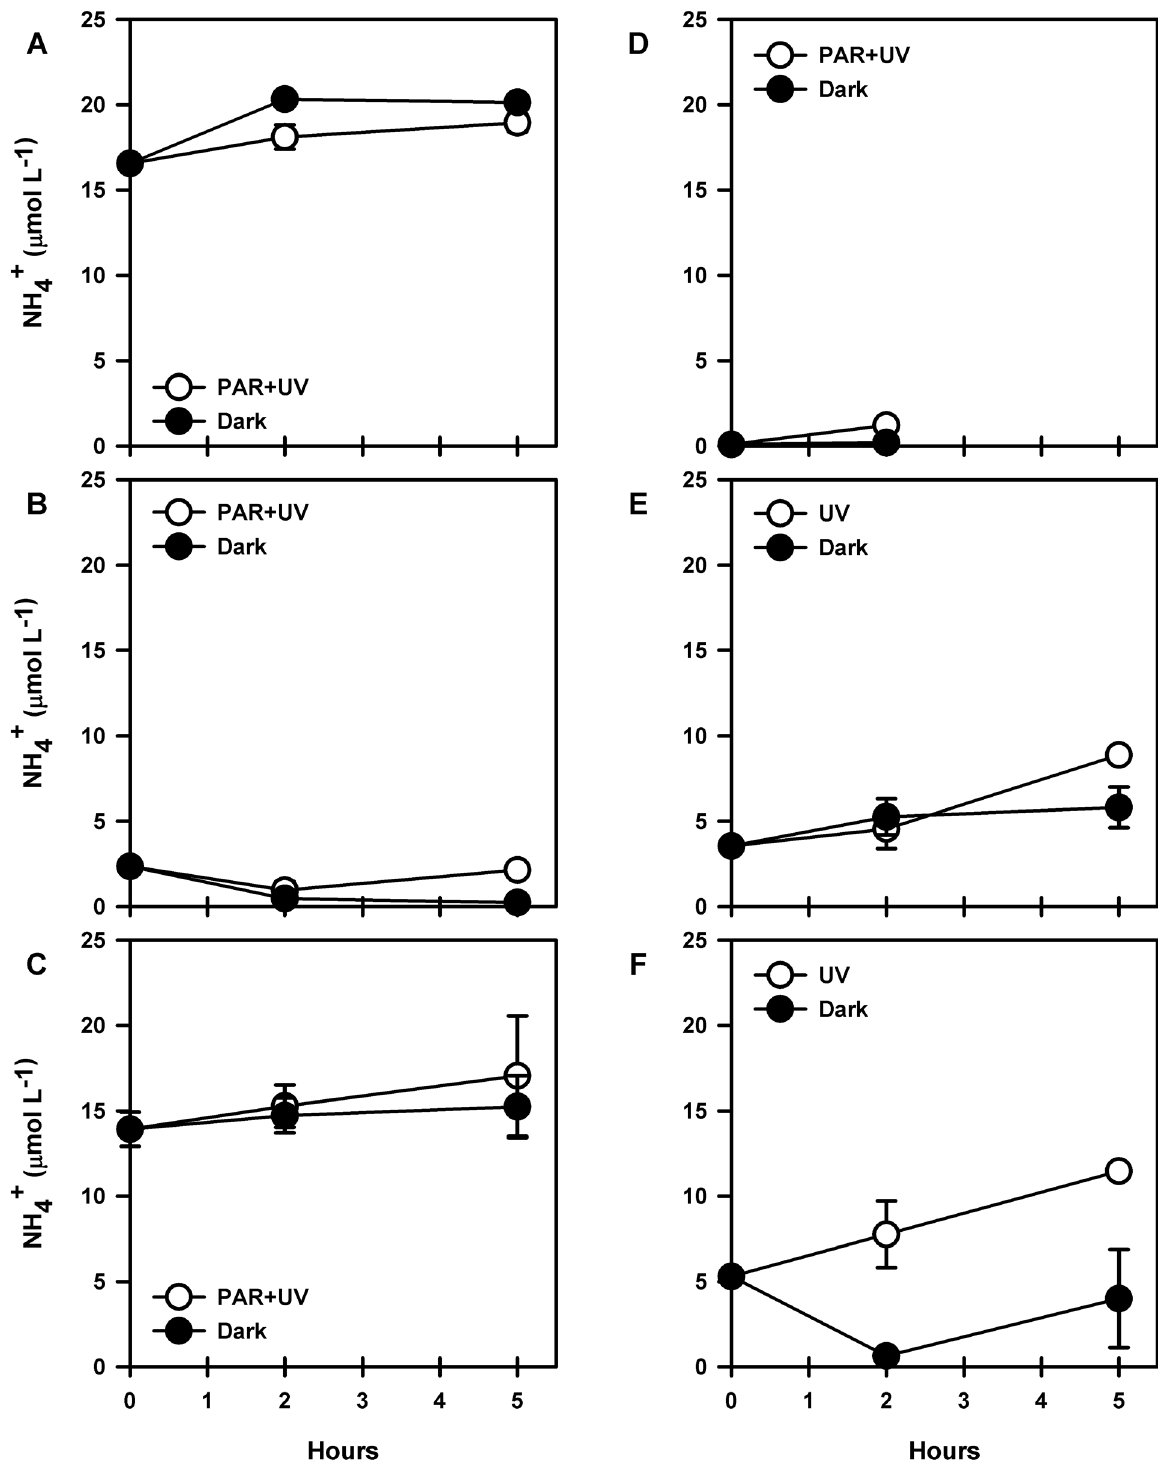
Figure 3. Evolution of ammonium concentrations during experiments of dissolved organic matter photodegradation using exudates of cultured C.muelleri at different cell densities (cell mL 2 1 ). A) 2.49E + 06, B) 2.52E + 06, C) 3.66E + 06, D) 3.97E + 06, E) 4.07E + 06 and F) 4.44E + 06. Error bar shows standard deviation for duplicate samples. doi:10.1371/journal.pone.0100224.g003 while remaining unchanged in dark samples. Values at T0 and 2.5 m mol L 2 1 for irradiated samples. Maximum concentra- (0.25 m mol L 2 1 ) increased 2 fold after 4 h of incubation (0.5 m mol tions for dark samples reached 1.7 m mol L 2 1 (Fig. 6C). Nitrite also showed an increase over time (Fig. 6D), but only for irradiated L 2 1 ). This suggests that ammonium consumption can be due to